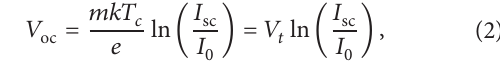
using a photovoltaic cell [20, 21]. Measurement of leaf area by image processing methods is fast, accurate, and stable, and leaf size, thickness, shape are of no effect, but this method can be neither used without a computer nor at the site [14, 22,